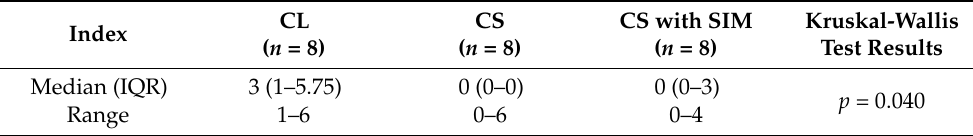
Table 3. Index summary between the experimental groups at 3